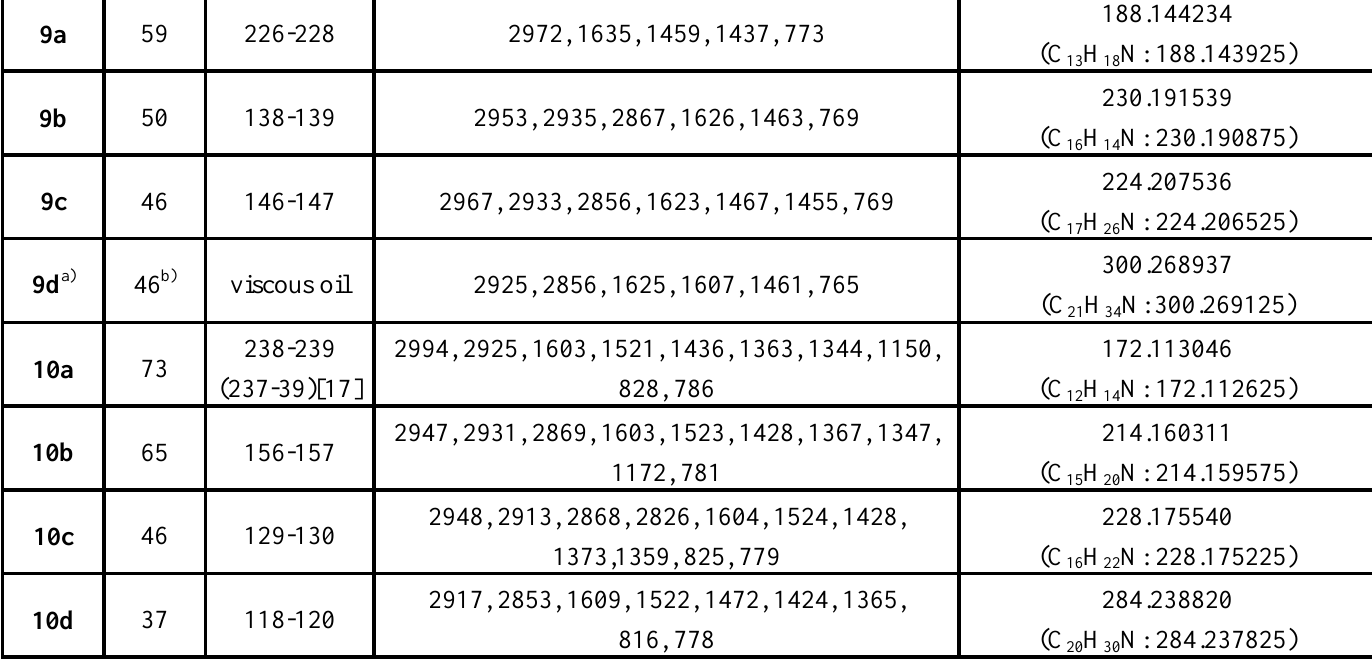
Table 2. Aliphatic 1 H-NMR spectral data of quaternary ammonium salts 6 - 10 (DMSO-d Salt